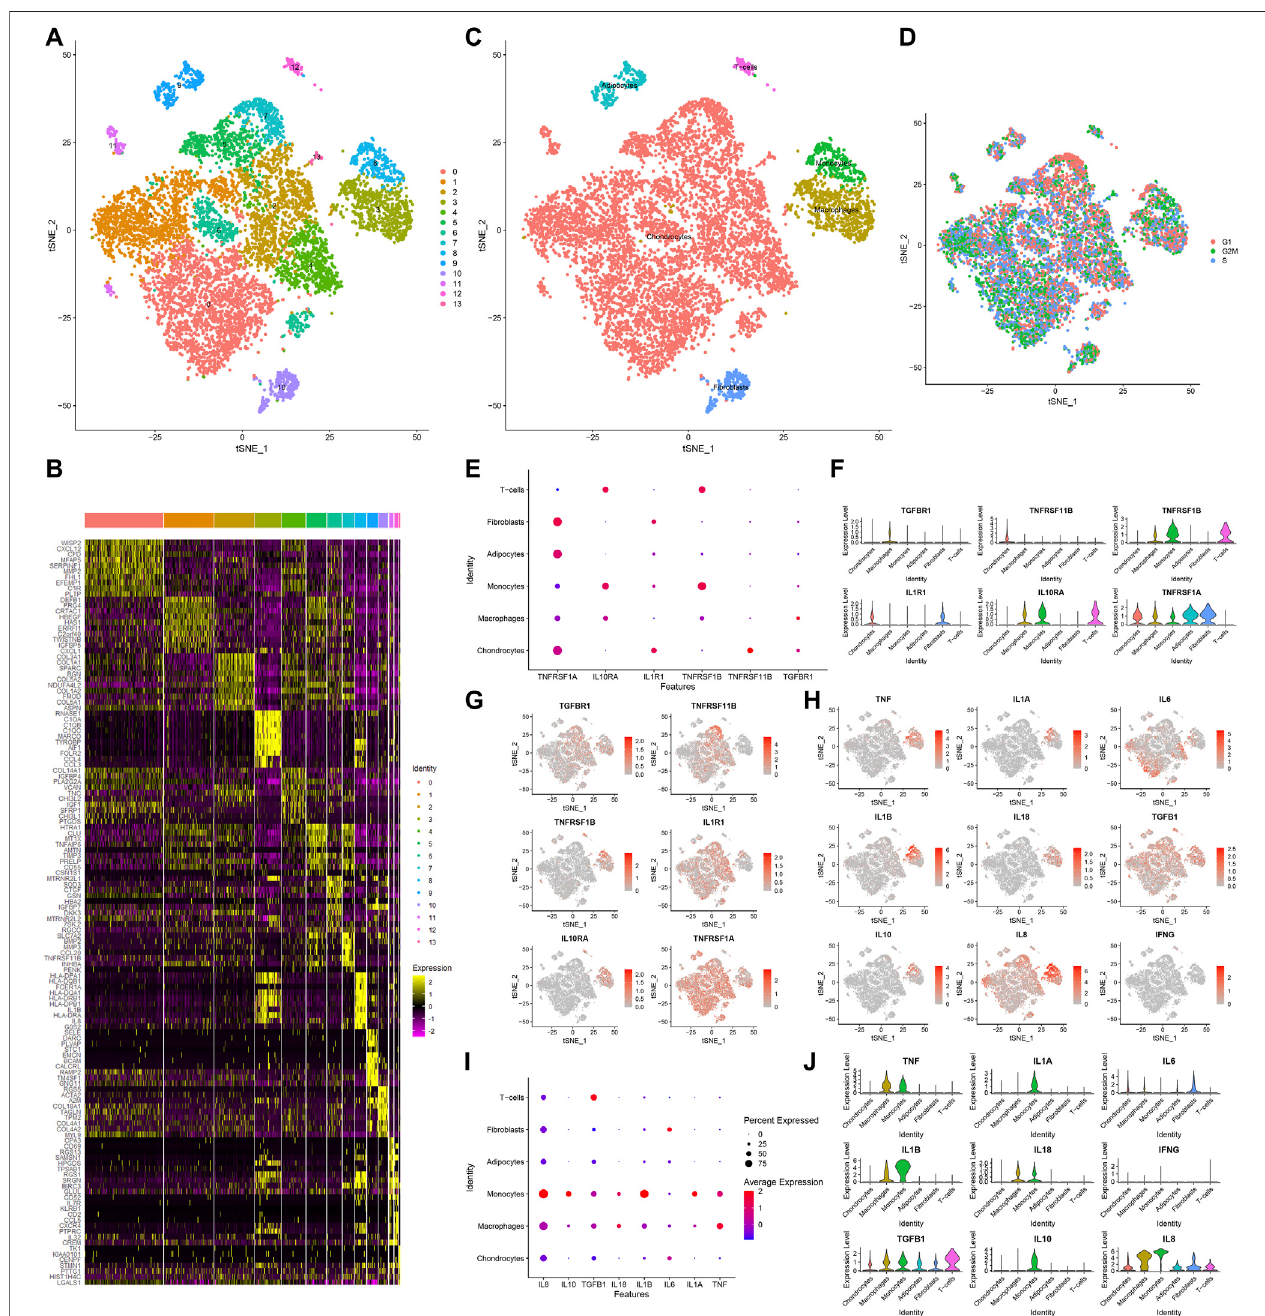
FIGURE 6 | Identi fi cation of cell clusters and marker genes in OA synoviocytes. (A) Visualization of cell clusters marked by different colors for OA synoviocytes by t-SNE method. (B) Heat map ofthescaled expressionsofthetop tenmarker-genesforeach cellcluster. (C) Annotation oft-SNE celltypes forOAsynoviocytes. (D) Cell cycle (G1, G2M, S) of OA synoviocytes on the t-SNE map. (E – G) Visualization of the expression levels of cytokine receptor marker genes for each cluster. (H – J) Visualization of the expression levels of in fl ammatory cytokine marker genes for each cluster.